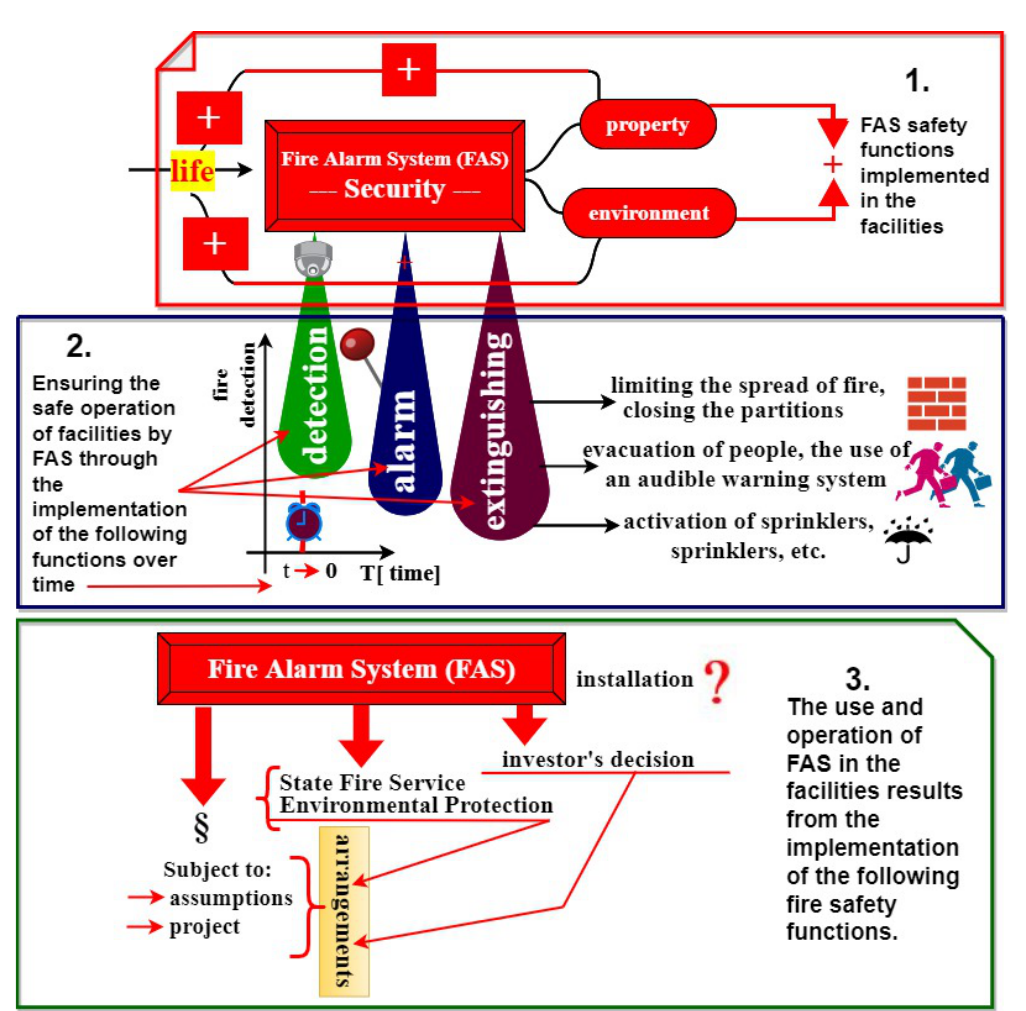
Figure 1. Fire safety and FAS use requirements in various facilities. Design, installation and subse-